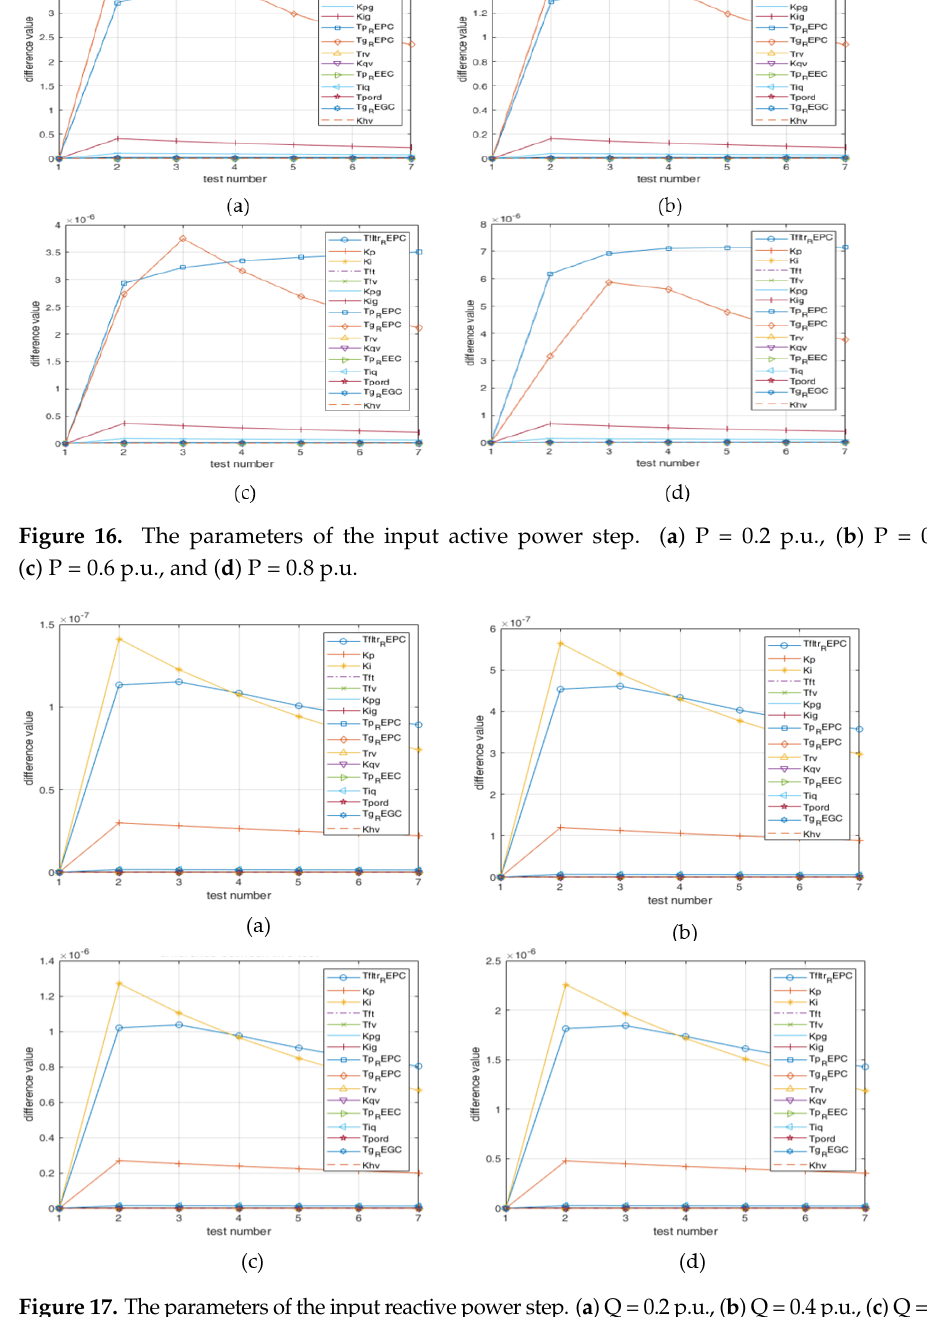
Figure 17. The parameters of the input reactive power step. ( a ) Q = 0.2 p.u., ( b ) Q = 0.4 p.u., ( c ) Q = 0.6 p.u., and ( d ) Q = 0.8 p.u .